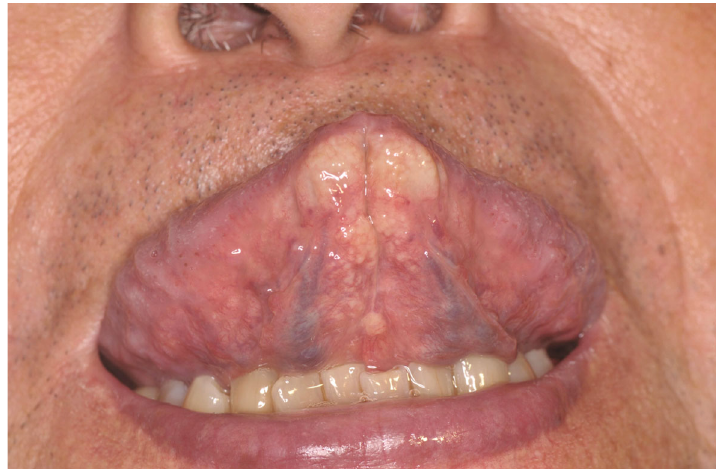
Figure 2: A collection of whitish-yellow papules is evident on the ventral surface of the tongue